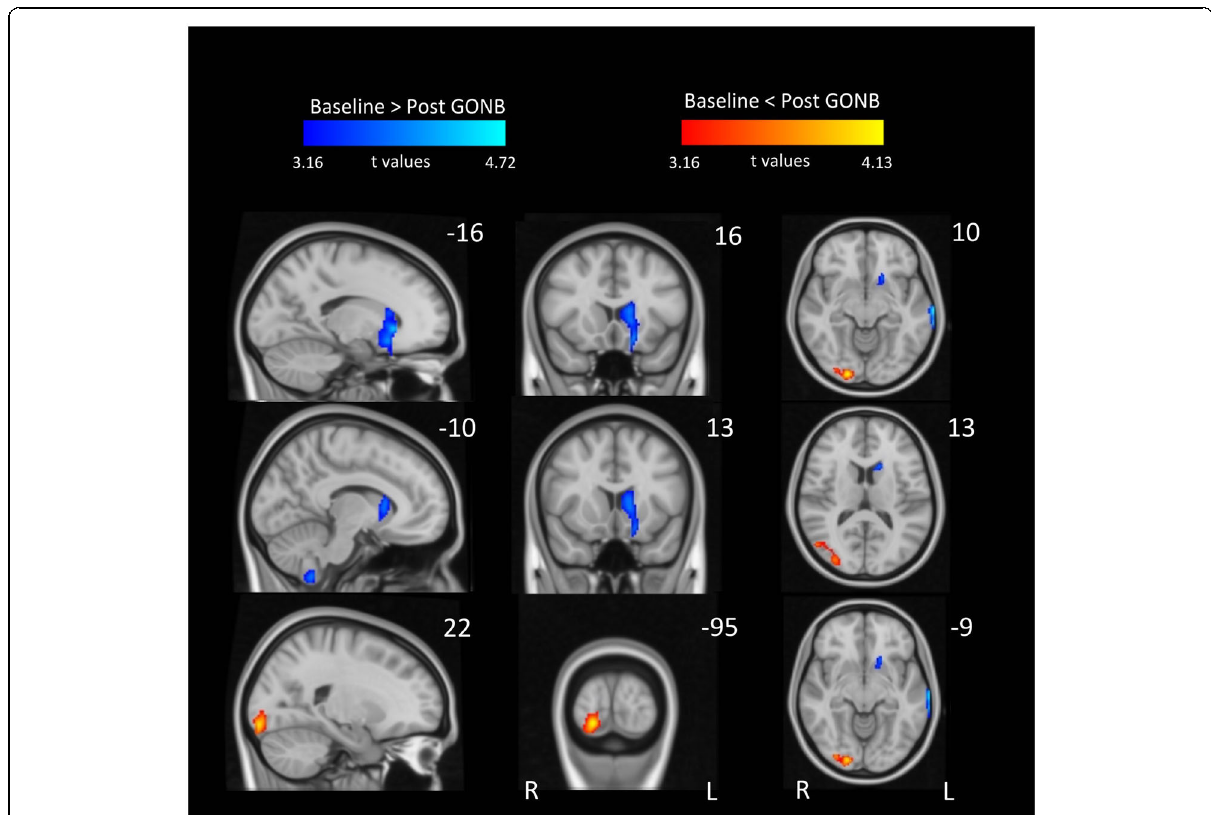
Fig. 2 Local decreases (blue) and increases (red) of rCBF across all CH patients following GONB. Brain areas in blue include medial temporal gyrus, cerebellum and substructures of basal ganglia including caudate and putamen. Cluster in red colour corresponds to secondary visual cortex. Data included four CBF maps per patient and session. All clusters are significant at p < 0.05 (FWE corrected; initial height threshold set to 0.001). GONB = greater occipital nerve block; R = right; L =